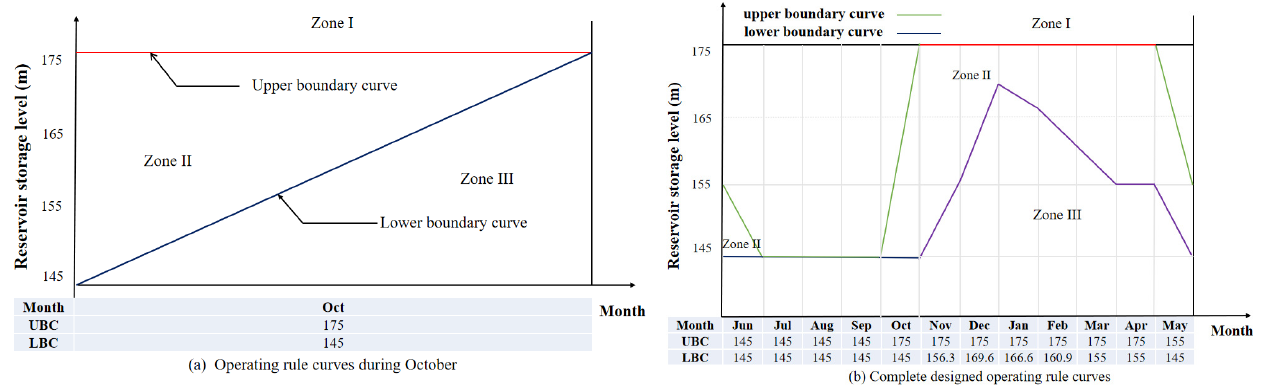
Figure 1. TG reservoir operating rule curves. UBC, upper boundary curve; LBC, lower bound- ary